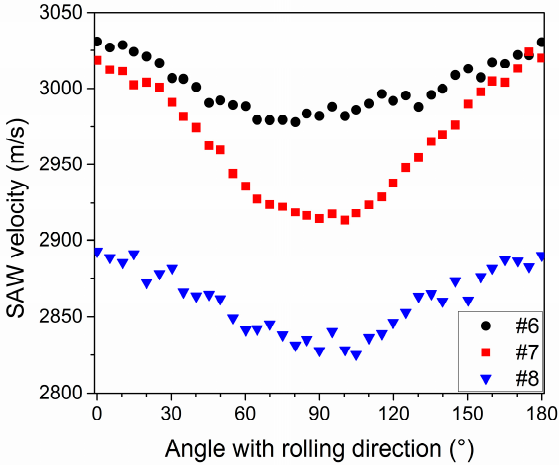
Figure 3. Angular dependence of surface acoustic waves (SAW) velocity in beginning (sample 6), during (sample 7) and after completion (sample 8) of recrystallization.